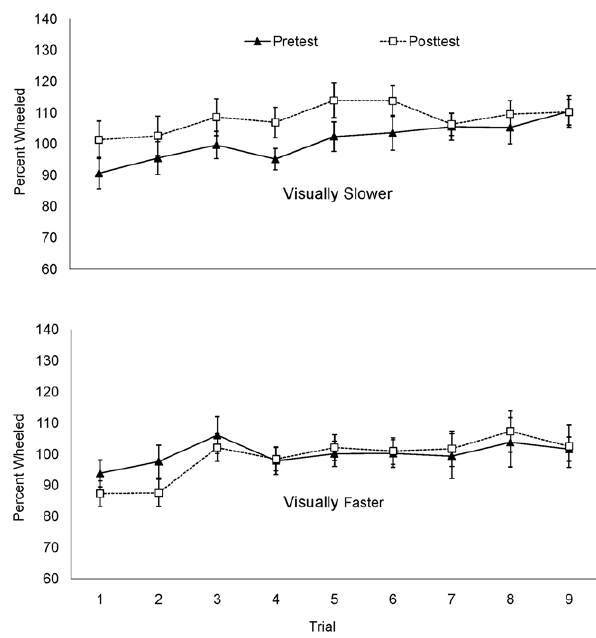
Figure 5. Percent wheeled by trial in Experiment 3.